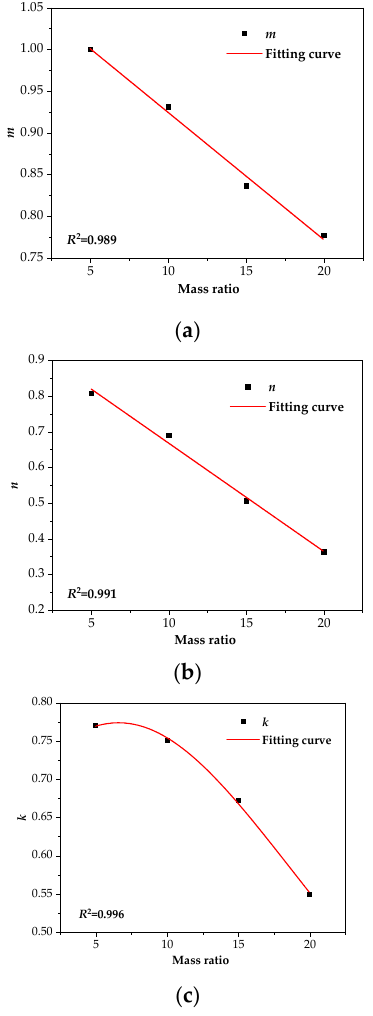
Table 7. The fitting results of each constant.